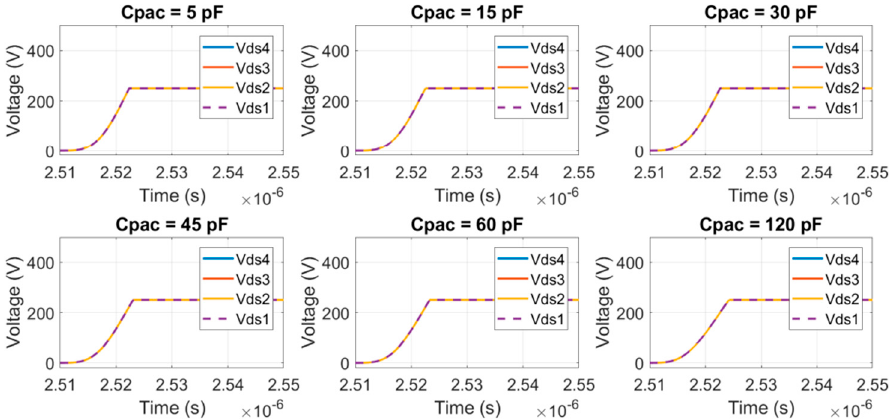
Figure 10. Simulation results of voltage-sharing performance between four series-connected SiC- MOSFETs in MSP.